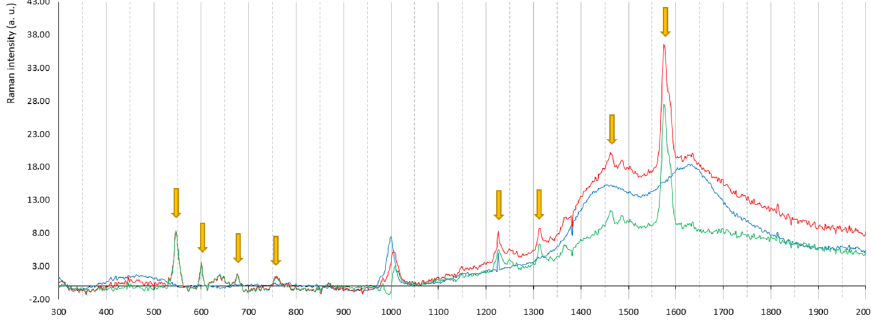
Figure 1. Average spectrum of the patient urine specimens from the renal pelvis (red line), from the drainage “blue” bag (blue line) and the difference spectrum between them (green line). Yellow arrows point out peaks located at 546 cm − 1 , 600 cm − 1 , 676 cm − 1 , 759 cm − 1 , 1226 cm − 1 , 1313 cm − 1 , 1461 cm − 1 , and 1573 cm − 1 in the urine from the renal pelvis spectrum that are not present in the urine from drainage “blue” bag spectrum.